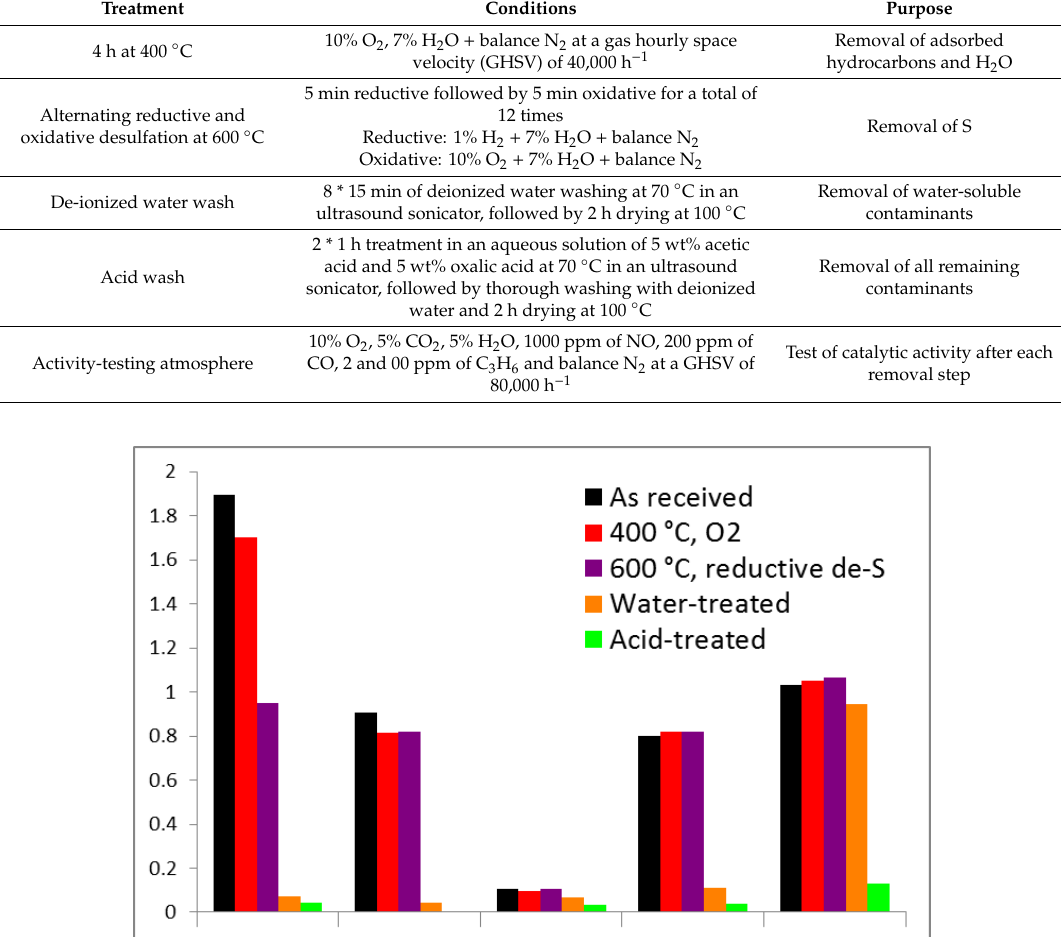
Table 1. Overview of the procedures used to selectively remove trace elements from the studied catalyst.